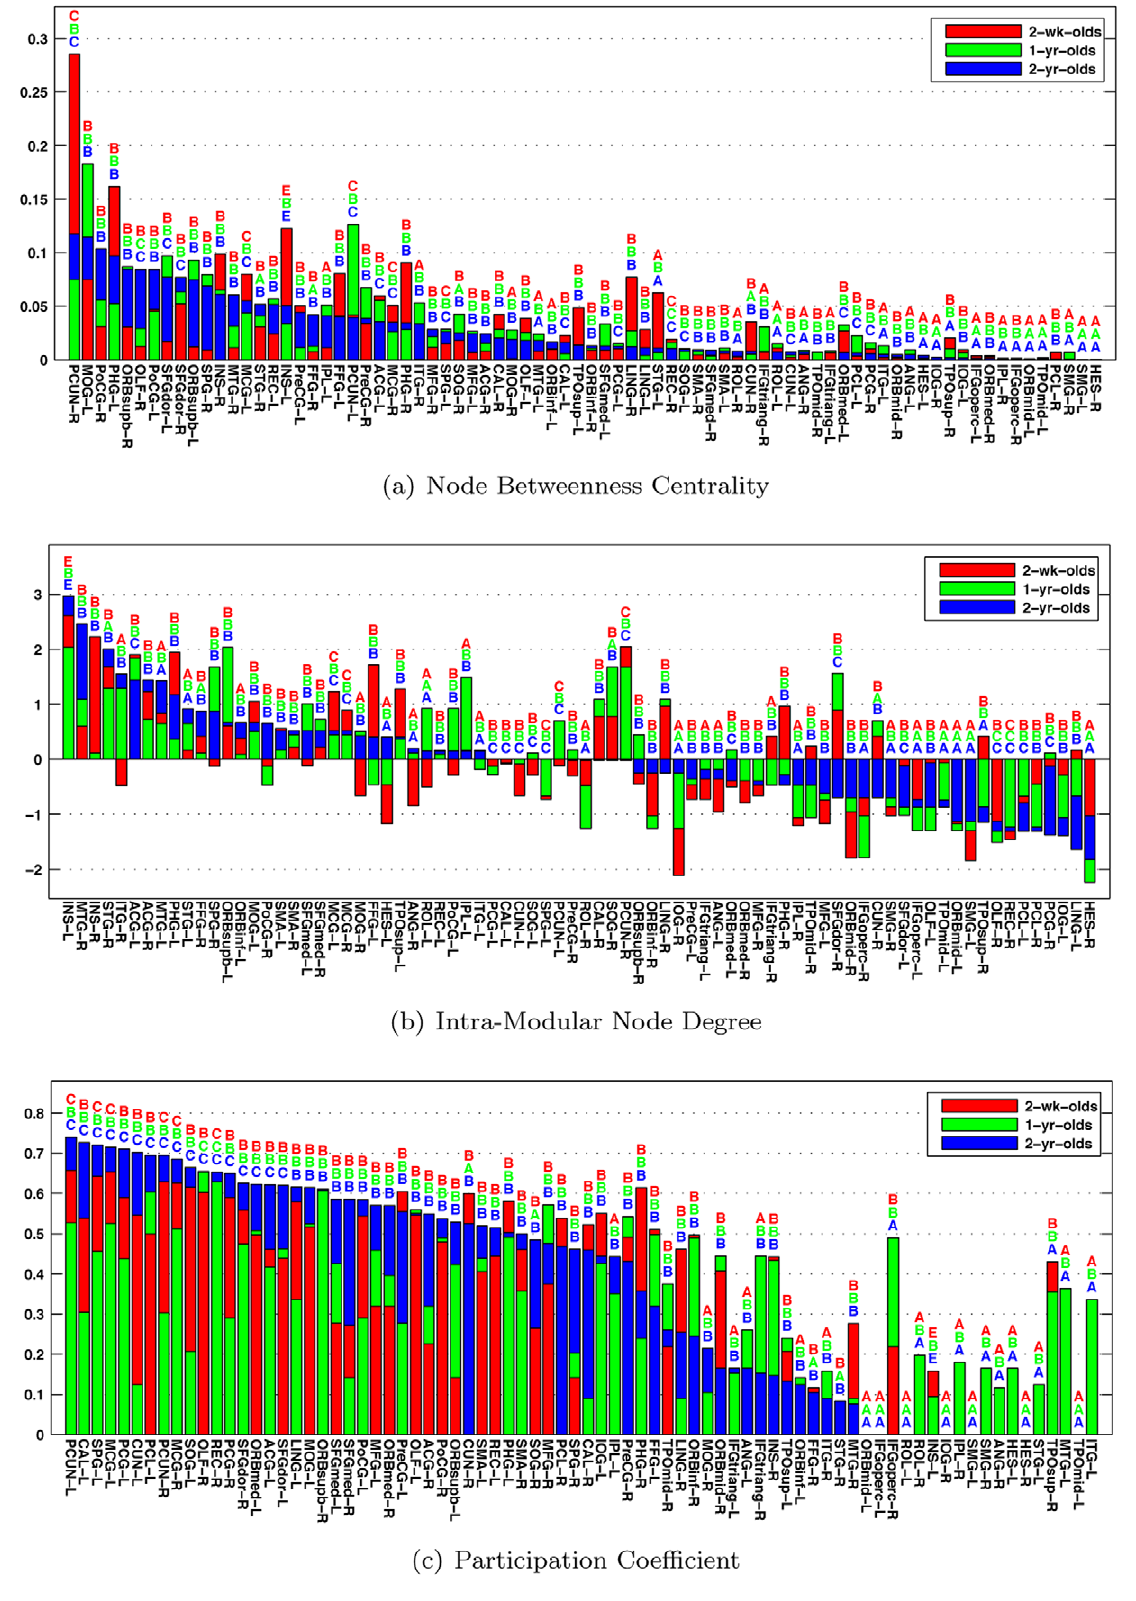
Figure 9. Betweenness Centrality, Intra-Modular Degree, and Participation Coefficient. The values are sorted based those of the 2-year- olds. The role of each node, as defined in [26], is specified above the respective bar: (A) non-hub ultra-peripheral node; (B) non-hub peripheral node; (C) non-hub connector nodes; and (D) non-hub kinless nodes; (E) provincial hubs; (F) connector hubs; and (G) kinless hubs. No node was found to satisfy the conditions required by (F) and (G).